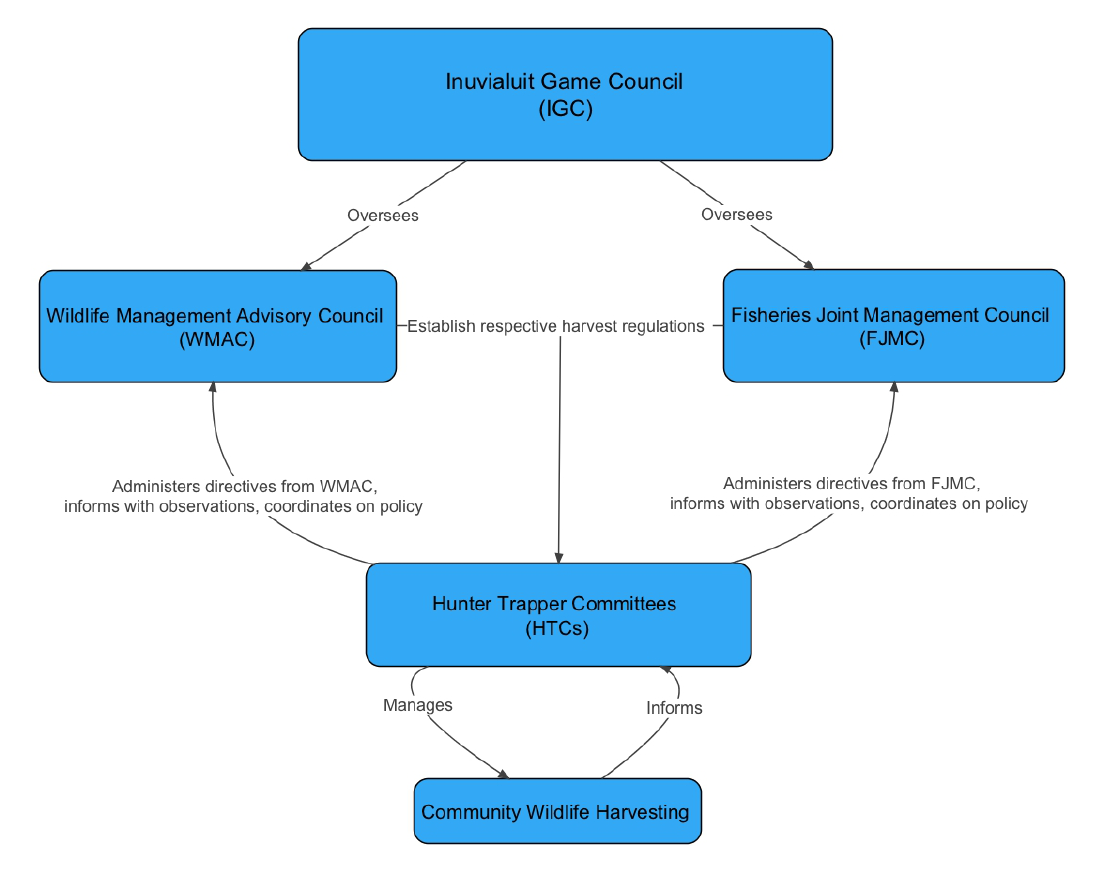
Fig. 1 . Vertical linkages between actors in the Inuvialuit Settlement Region. Information flows in both directions as community wildlife harvesters contribute observations and concerns to Hunter Trapper Committees and higher level management bodies, which establish policy and management quotas based on multiple sources of